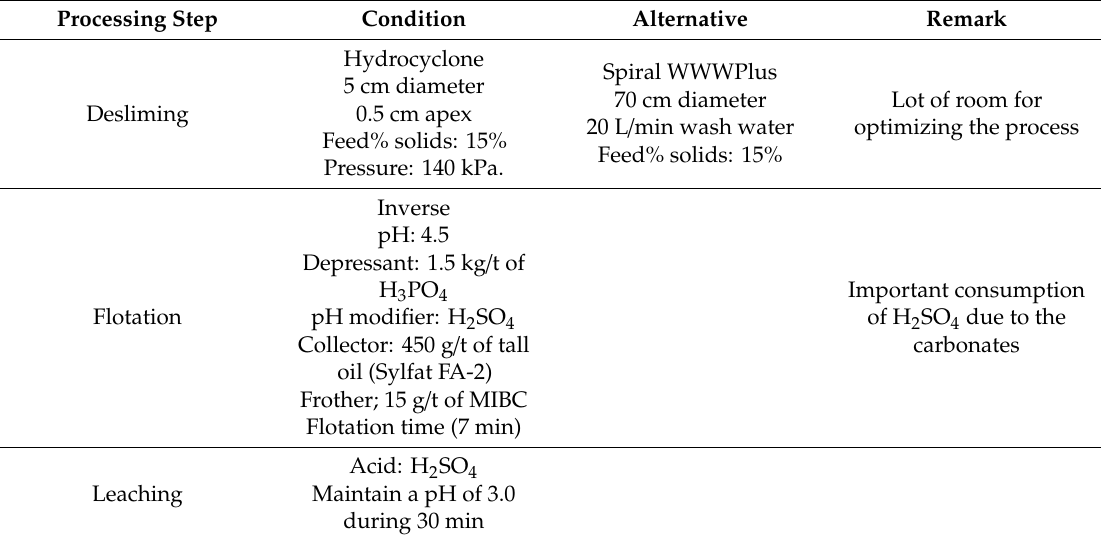
Table 10. Summary of the operating conditions for the processing of the CC.